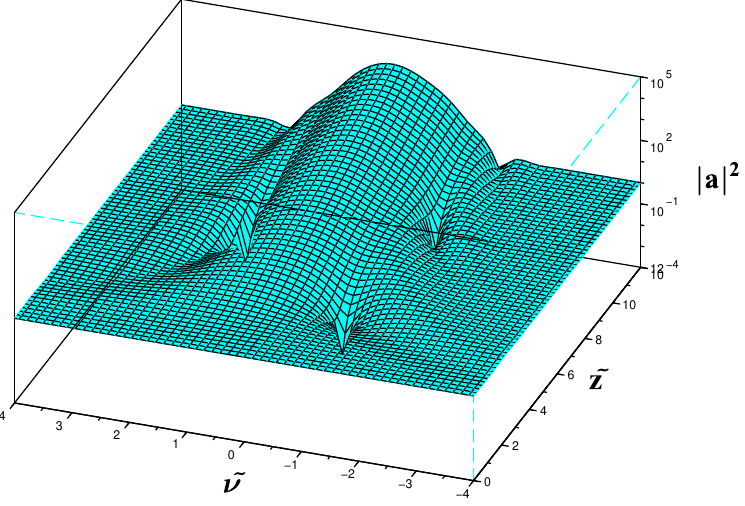
Figure 6. Intensity vs. ˜ z , ˜ ν for inhomogeneous parameters ˜ µ ε = 1, g 0 = 100, a 0 =